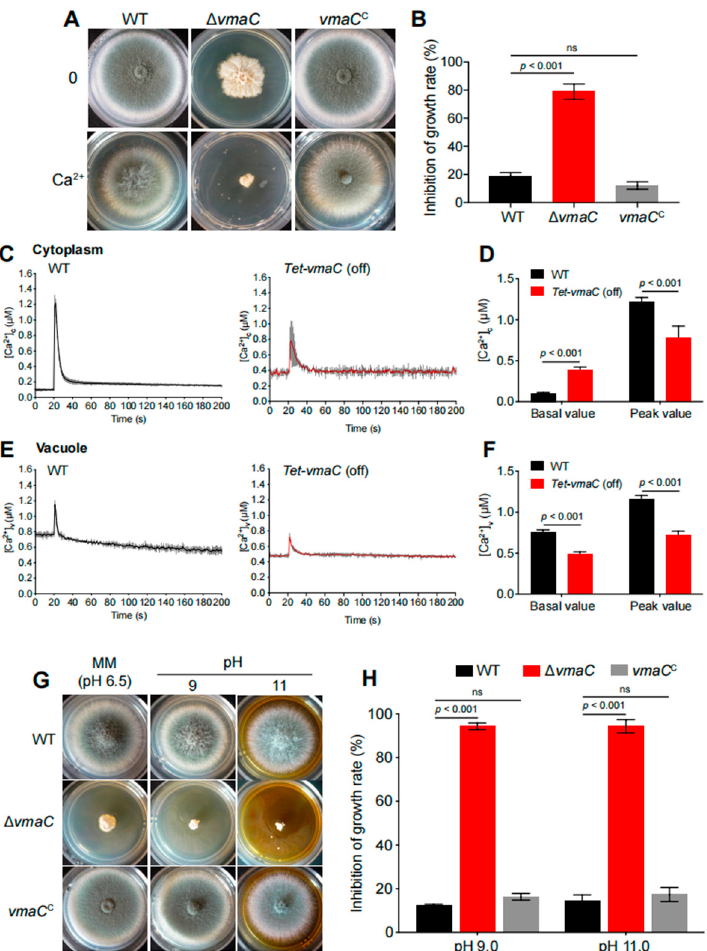
Figure 3. High calcium concentrations and high pH are toxic to vmaC mutants. ( A ) Colony morphology of Δ vmaC in response to an extracellular calcium stimulus at 37 °C for 2 days. ( B ) The growth inhibition rate of Δ vmaC when treated with 500 mM calcium (ns, not significant). ( C ) Linear graphs indicating the real ‐ time [Ca 2+ ] c changes in response to calcium stimulus. [Ca 2+ ] c , the free Ca 2+ concentration in the cytosol. ( D ) The comparison of [Ca 2+ ] c of WT and Tet ‐ vmaC (off) in resting and dynamic levels. The basal value is the resting level prior to the extracellular calcium stimulus. The peak value is the peak level after the extracellular calcium stimulus. Data are the average of three experiments. Error bars show the standard deviation. Statistical significance was determined by Student’s t ‐ test. ( E ) Linear graphs indicating the real ‐ time [Ca 2+ ] v changes in response to calcium stimulus. [Ca 2+ ] v , the free Ca 2+ concentration in vacuoles. ( F ) The comparison of [Ca 2+ ] v of WT and Tet ‐ vmaC (off) in resting and dynamic levels. ( G ) The morphology of mycelial pellets of the WT and Δ vmaC strains under pH = 4, pH = 9, and pH = 11 conditions. ( H ) The growth inhibition rate of Δ vmaC when treated with pH 4, pH 9, and pH 11, respectively (ns, not significant).